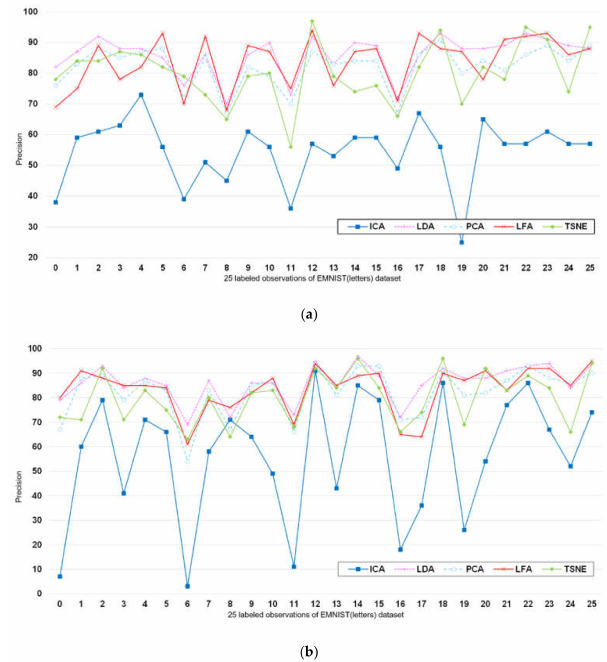
Figure 13. Results of precision and recall evaluation by the feature extraction algorithm in a support vector machine (SVM). ( a ) Precision measurement data using SVM. ( b ) Recall measurement data using SVM.